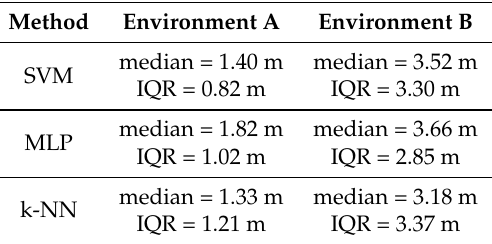
Table 2. Median error and interquartile range (IQR) of fingerprint-based methods in Environment A and Environment B using four beacons and a fingerprint grid with one measurement every 0.5